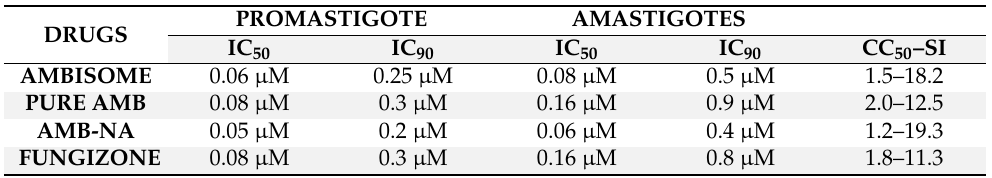
Figure 4. Parasiticidal potential of as-synthesized AmB-NA against L. donovani . The parasiticidal potential of the as-synthesized AmB-NA was determined on the basis of residual intracellular parasite load in peritoneal exudate macrophage in response to antileishmanial activity incurred by AmB-NA post 48 h of incubation with L. donovani . ( A ) Uninfected macrophages served as a negative control, ( B ) L . donovani infected macrophages, ( C ) Macrophages with reduced parasite load post-AmB-NA single-dose treatment, and ( D ) Macrophages representing a reduction in parasite load post-AmB-NA double dose treatment. ( E ) Graph demonstrating IC 50 and IC 90 for various AmB formulations against promastigote and amastigote. Fungizone-, pure Amphotericin B-, AmBisome-based formulations were included as the control. Table 2. In vitro antileishmanial activities (IC 50 and IC 90 ) of AmB-NA compared to those of Fungizone and AmBisome in macrophages infected with L. donovani amastigotes, observed after 48 h of incubation. CC 50 was estimated after 48 h of drug treatment to macrophages. The SI represent the selectivity index calculated by dividing the CC 50 by the IC 50 value obtained after treatment of cultured macrophages after 48 h.